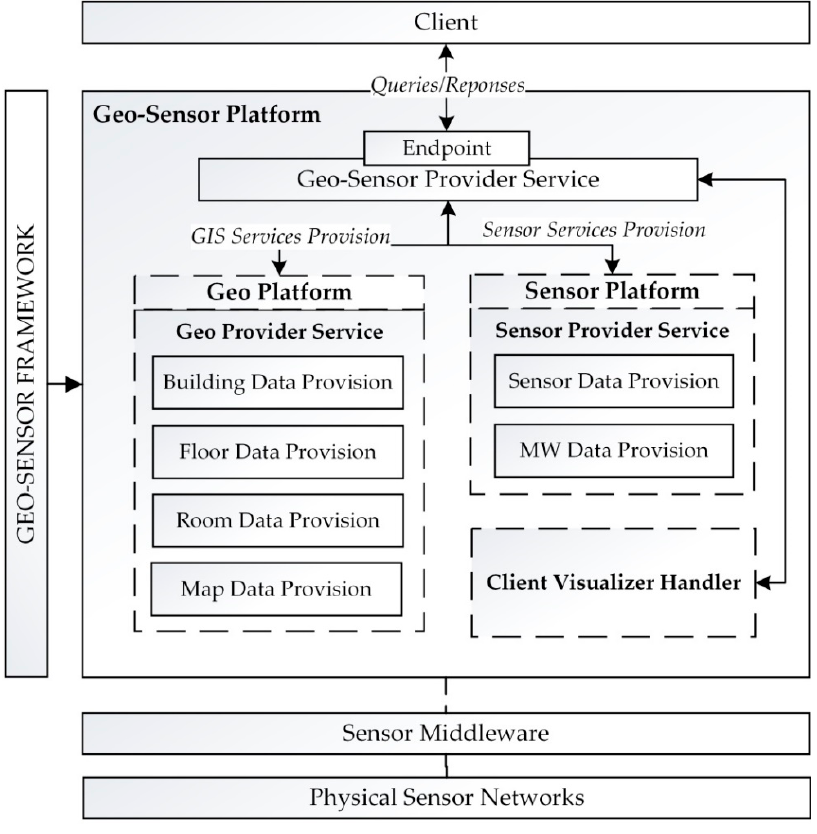
Figure 4. Proposed geo-sensor platform configurations.